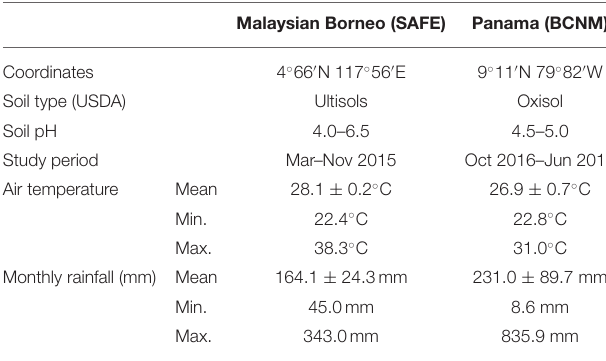
TABLE 1 | Comparison of study sites for a mesocosm experiment comparing soil properties, litter decomposition, and soil respiration in forested and converted sites in Malaysian Borneo and Panama, Central America, where SAFE is the Stability of Altered Forest Ecosystems project in Malaysian Borneo and BCNM is the Barro Colorado Nature Monument in